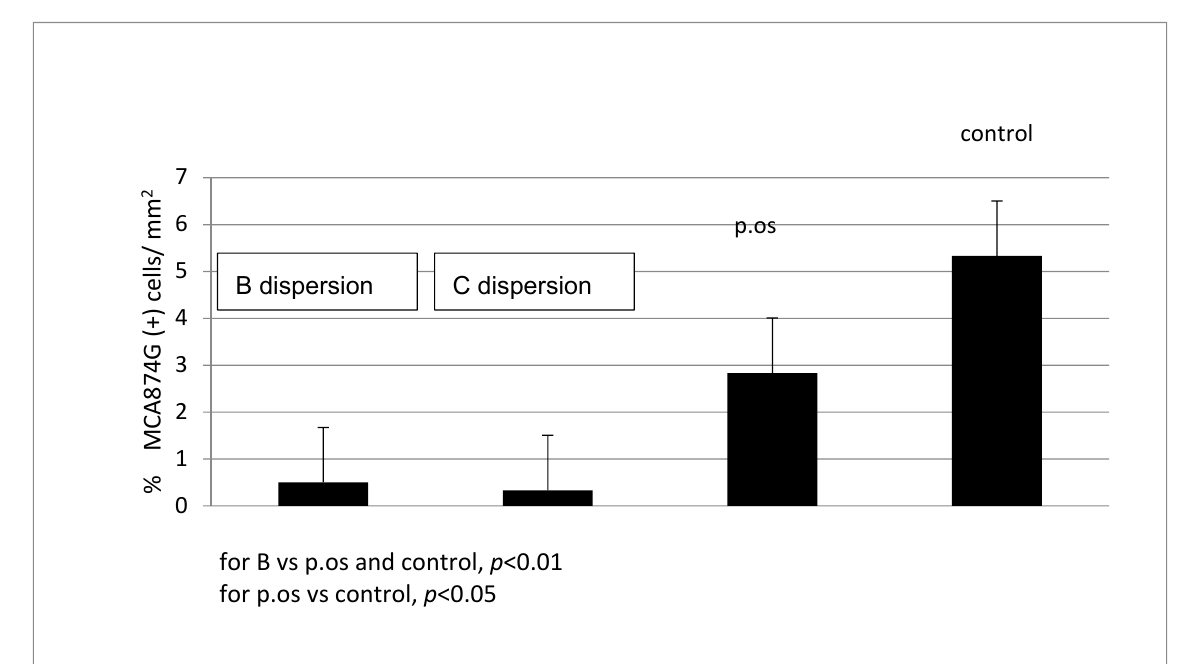
Figure 9. The presence of macrophages in the vessel wall (aorta) after 28 days (groups receiving B and C SVPLA vs. p.os and control). SV dispersion concentration; B: 0.1750 mg/mL, C: 0.0875 mg/mL. SV orally 0.6 mg/kg; Control; saline 0.9% NaCl. Each group n = 6; six vascular samples (aorta) were tested per animal (total 36 per group). Table 3. Total cholesterol levels (mmol/L) in rat blood serum, depending on the time scale of